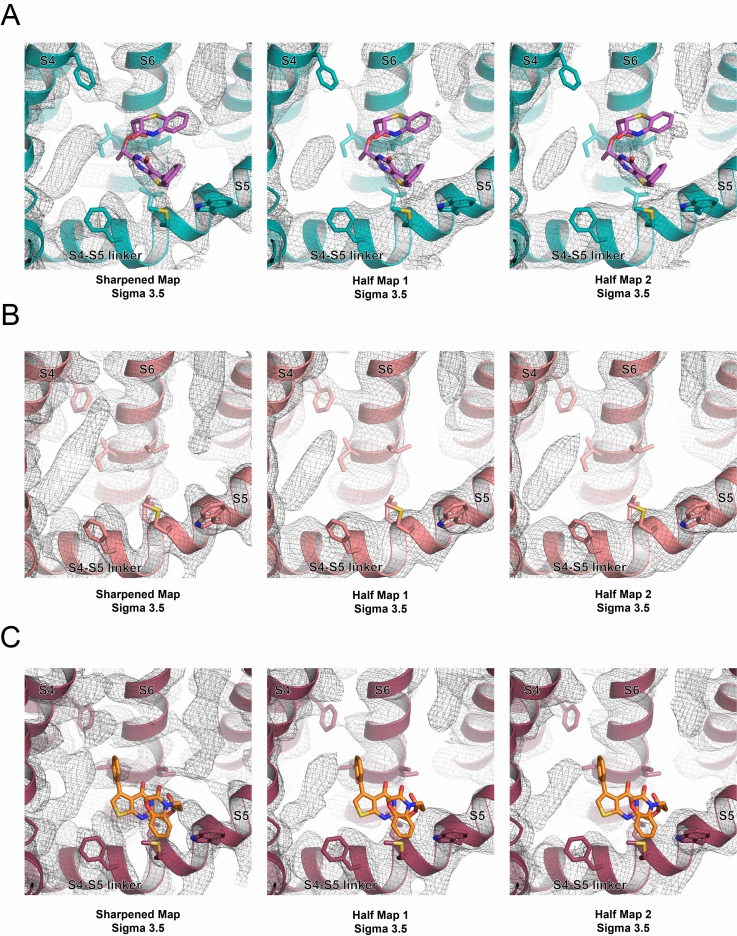
Cryo-EM half maps of the S4-S5 binding pocket.(A) The S4-S5 binding pocket in the sharpened map (left), half map 1 (center) and half map 2 (right) of ZINC9155420-bound TRPV5. One potential pose of bound ZINC9155420 is shown as pink sticks. (B) The S4-S5 binding pocket in the sharpened map (left), half map 1 (center) and half map 2 (right) of lipid-bound TRPV5 (PDB: 6DMR, EMB-7965). (C) The S4-S5 binding pocket in the sharpened map (left), half map 1 (center) and half map 2 (right) of ZINC17988990-bound TRPV5. One potential pose of bound ZINC17988990 is shown as orange sticks. The density maps are shown as gray mesh.